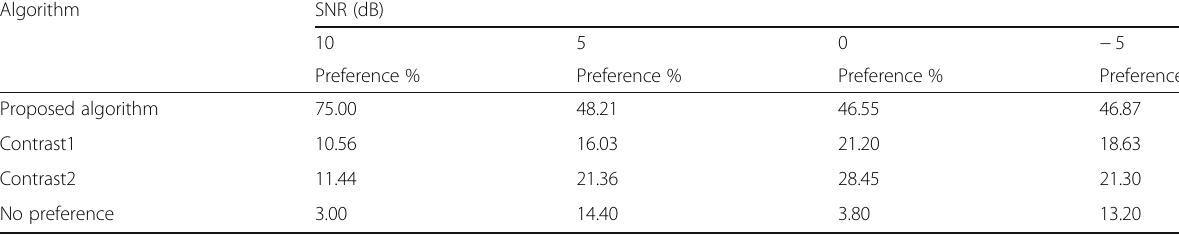
Table 7 The A/B test of the proposed algorithm and the contrast algorithm at different SNRs